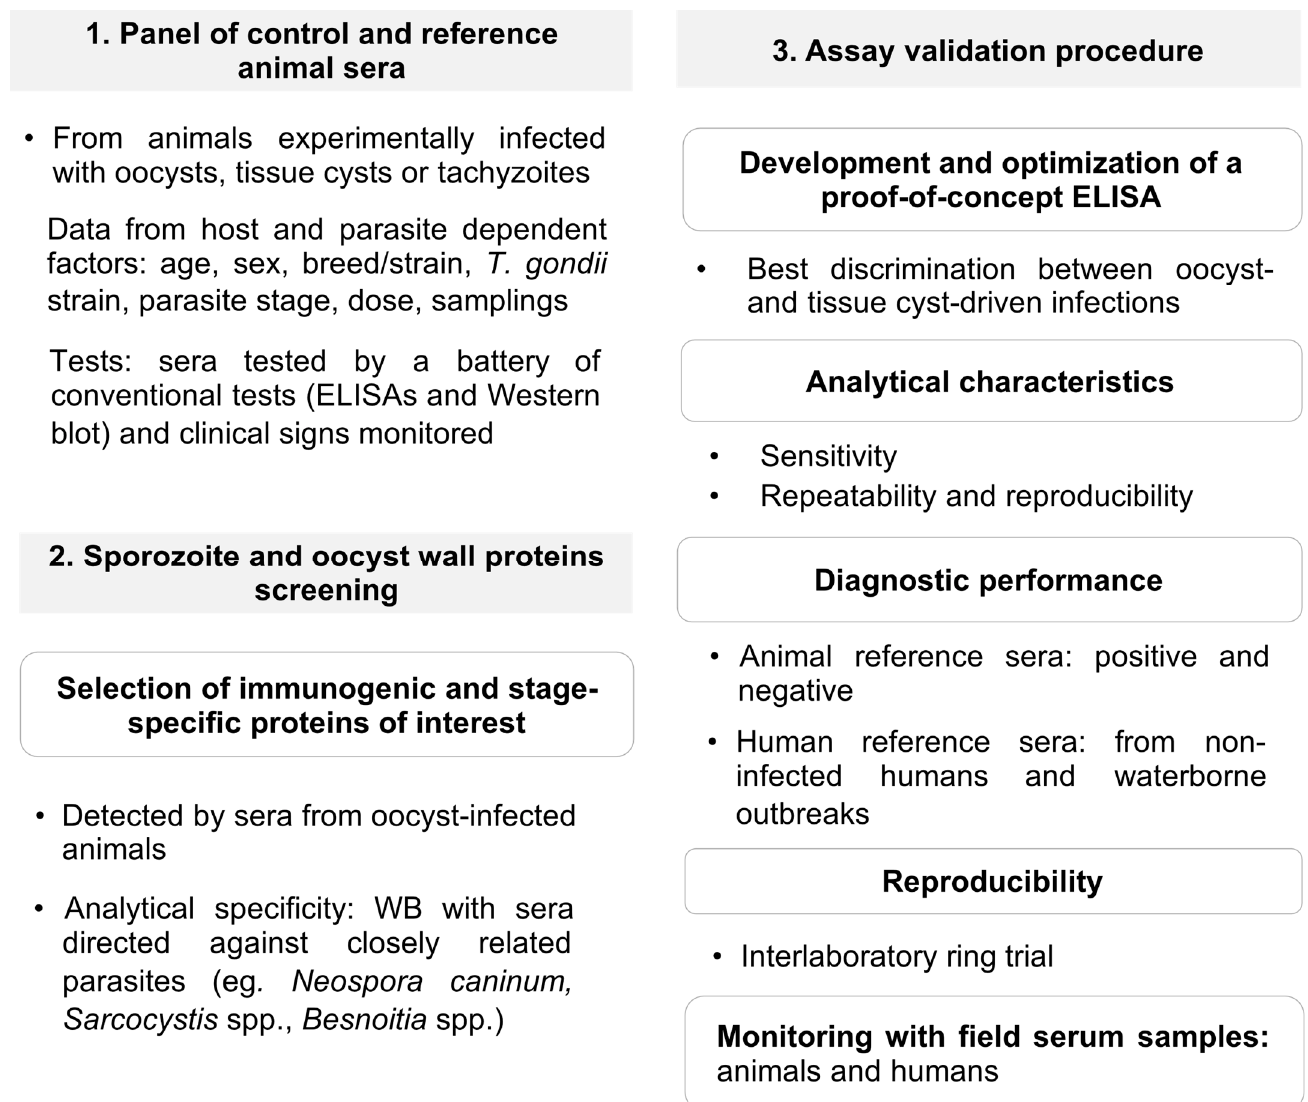
Figure 2. Workflow to develop an assay to differentiate oocyst-driven infections vs. tissue cyst-driven infections from a One Health perspective and according to OIE guidelines.